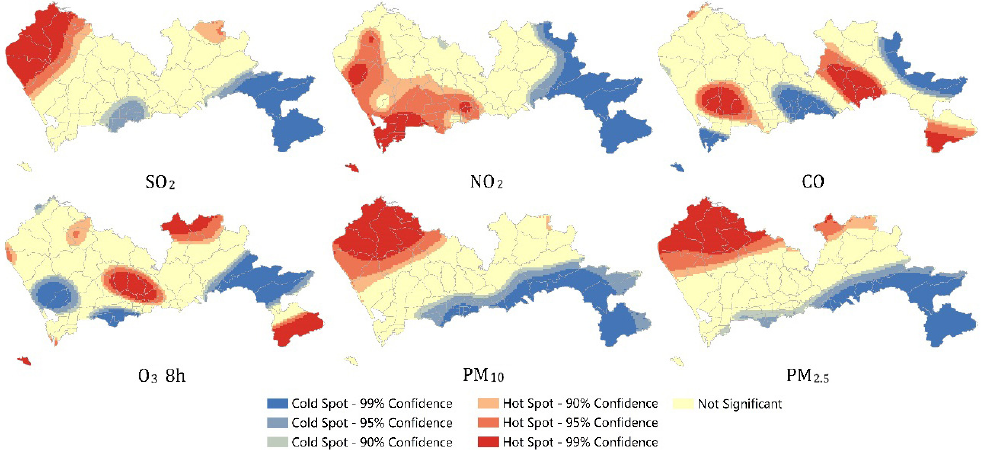
Figure 7. Spatial agglomeration of air pollutants in Shenzhen from March 2013 to February 2014.